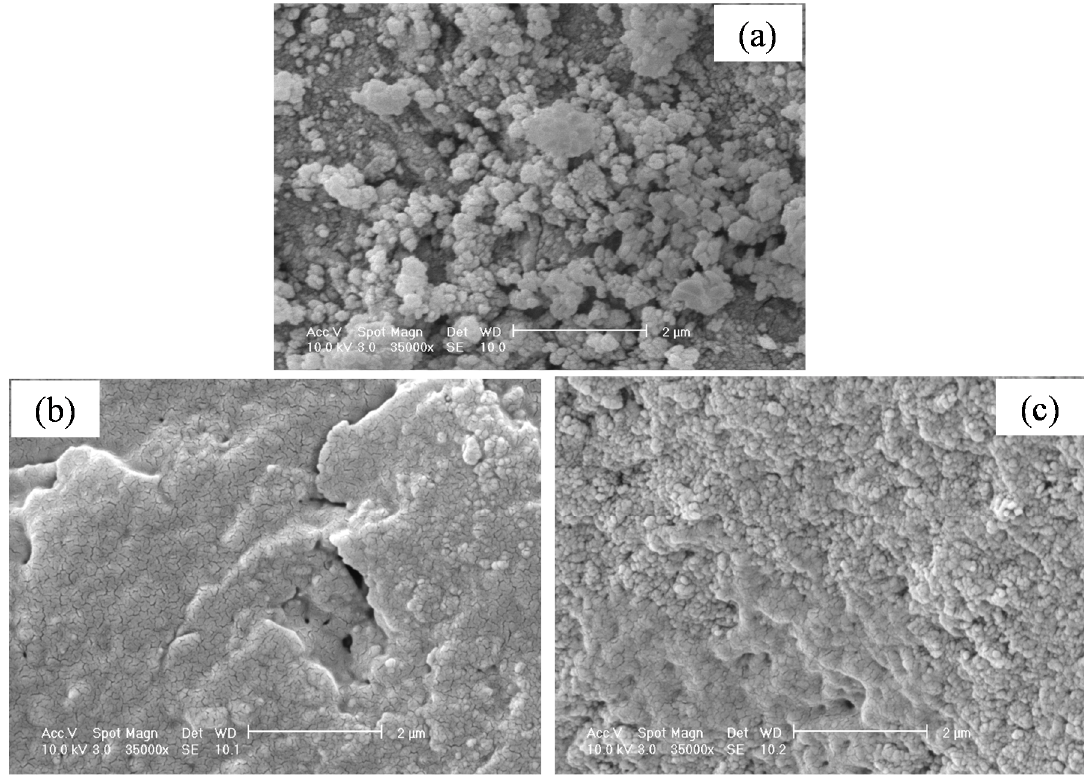
Figure 7. SEM photomicrograph ( a ) fresh CoMo/Alumina; ( b ) spent CoMo/Alumina after upgrading with N 2 and ( c ) spent CoMo/Alumina after upgrading with H 2 .